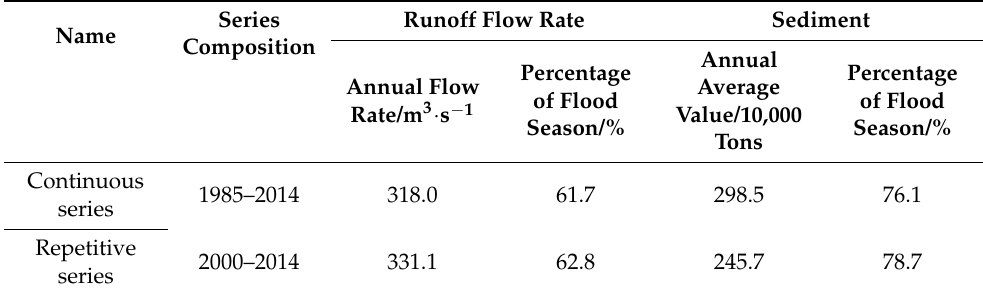
Table 3. Statistics of hydro-sediment volume in the river under different flow–sediment